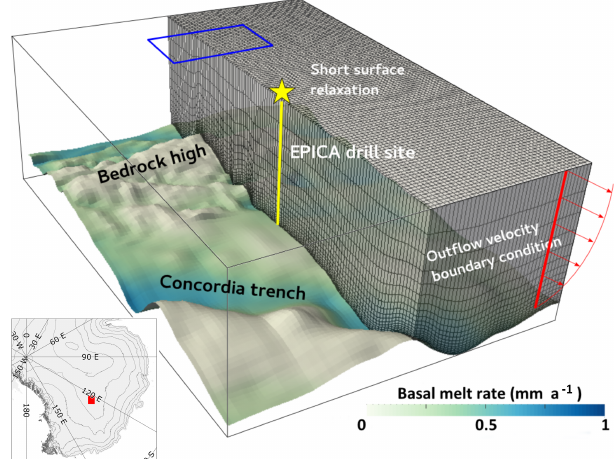
Figure 1. Mesh, bedrock dataset (Fretwell et al., 2013; Young et al., 2017) and basal melt rate (Passalacqua et al., 2017) used for the simulation on a 83 × 114km domain. The red patch on the context map (bottom left) shows the domain used for the calculation, and the blue rectangle at the top of the image is the location of Fig.